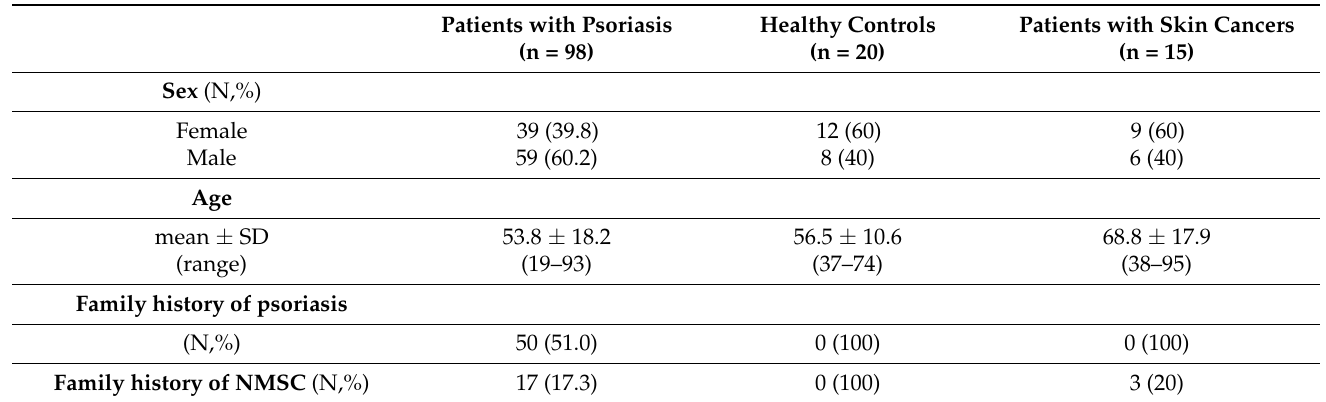
Table 1. Demographics and clinical features of patients with psoriasis and healthy controls. Patients with